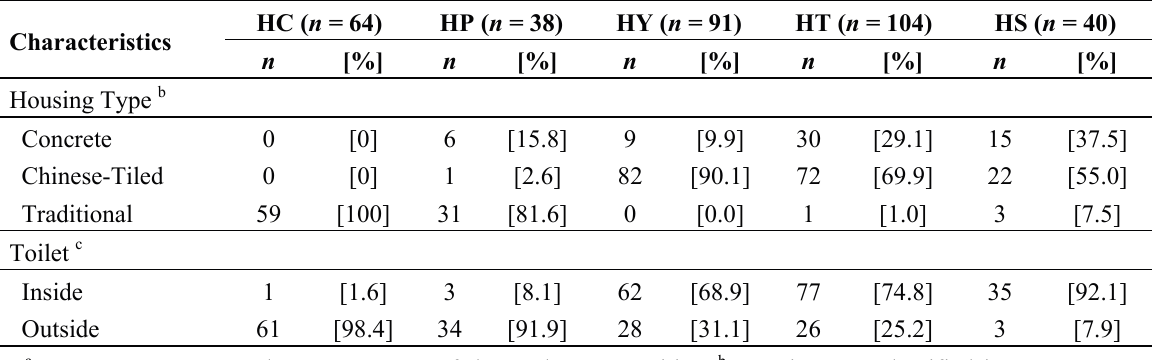
Table 1. Household characteristics by community a